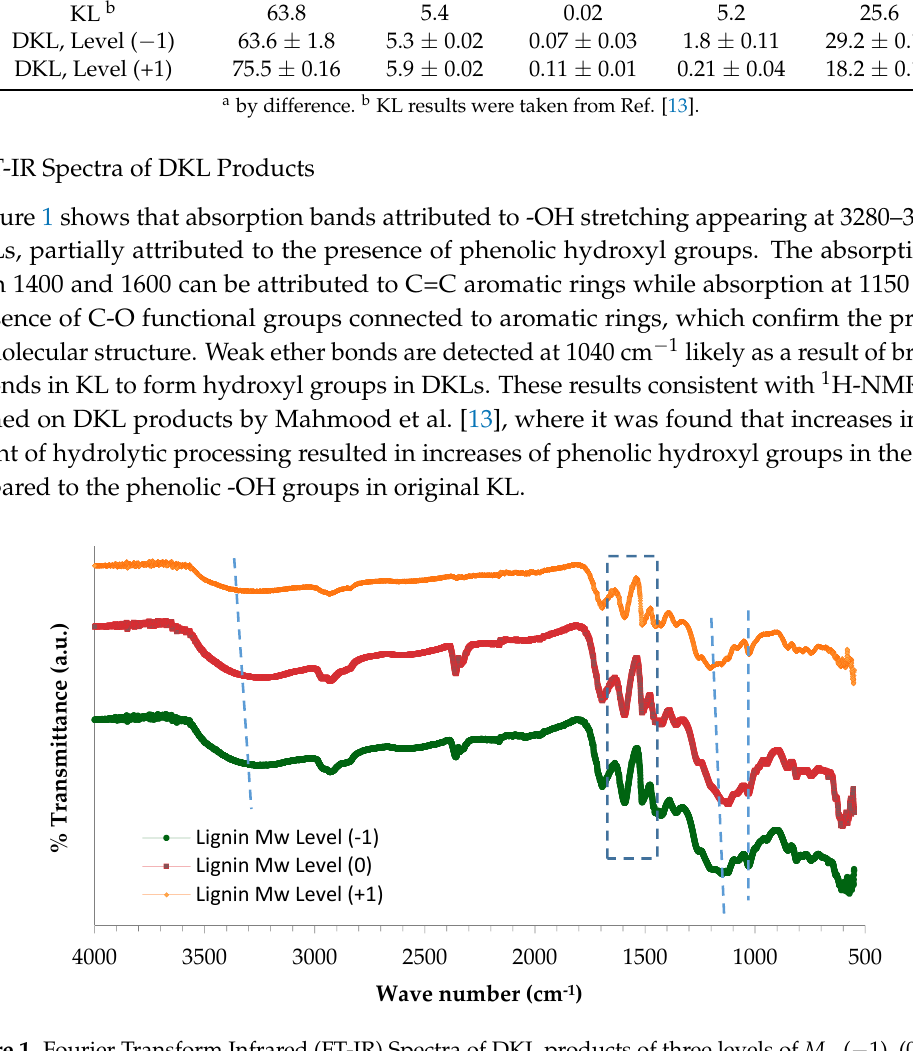
Table 3. Viscosity of all BPF resoles synthesized in this study.